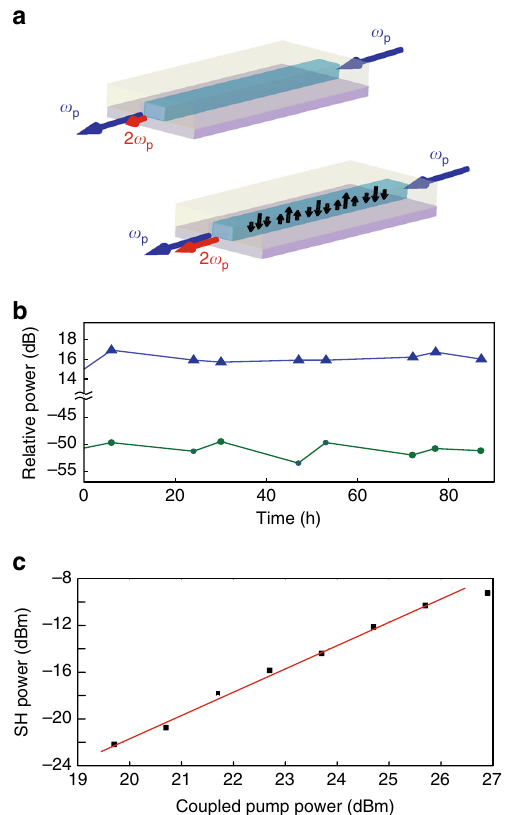
Fig. 4 Grating dynamics and evaluation of its parameters. a Illustration of the χ (2) grating inscription in a SiN waveguide. After irradiation, a spatially periodic DC fi eld builds up with a periodicity that is twice the coherence length between the pump and second harmonic mode. ω p indicates the pump frequency. b Persistence measurement showing the continuous wave probe (blue triangles) and second harmonic (green circles) power over more than 80 h of operation. Both quantities were measured at the waveguide output. c Second harmonic power (estimated in waveguide (i)) as a function of the coupled continuous wave probe power. The probe is centred at 1544 nm, and the grating was previously inscribed at the same wavelength. The squares are experimental points while the red line is a linear fi t with a slope of 2. The observed saturation at high power